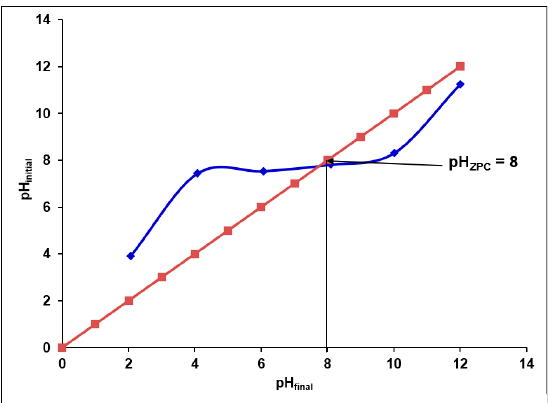
Figure 5. Determination of the zero point charge (pH ZPC ) of synthesized alumina nanoparticles.